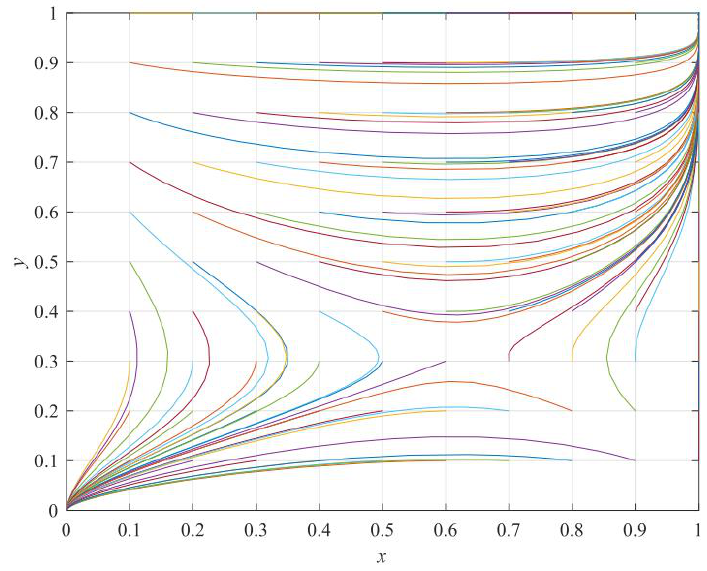
Figure 8. The dynamic diagram of SMEs and LFs.